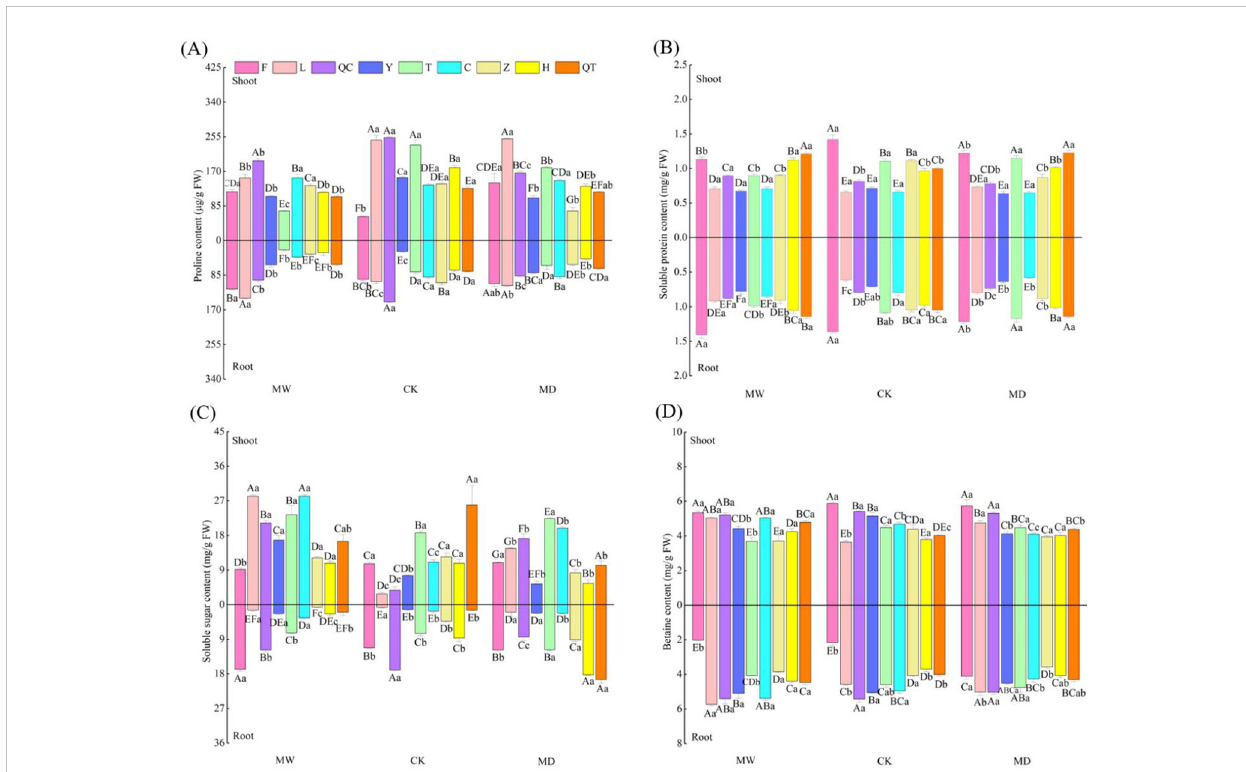
FIGURE 2 Proline (A) , soluble protein (B) , soluble sugar (C) and betaine (D) contents in shoots of nine selected plant species under different water regimes, including control (CK), moderate drought (MD) and moderate waterlogging (MW). Plant species include Deschampsia caespitosa (F), Poa crymophila Keng (L), Poa pratensis L. cv. Qinghai (QC), Festuca sinensis Keng ex S. L. Lu (Y), Puccinellia tenui fl ora (Griseb.) Scribn.et Merr.cv. Tongde (T)>, Elymus nutans Griseb. (C), Kobresia tibetica (Z), Blysmus sinocompressus Tang et Wang (H), and Carex moorcroftii Falc. Ex Boott (QT). Different lowercase letters within the same row indicate that there are signi fi cant differences between water regimes for the same plant species at P <0.05 and different capital letters within the same column indicate that there are signi fi cant differences between plant species under the same water condition at P <0.05. Bars represent the standard error